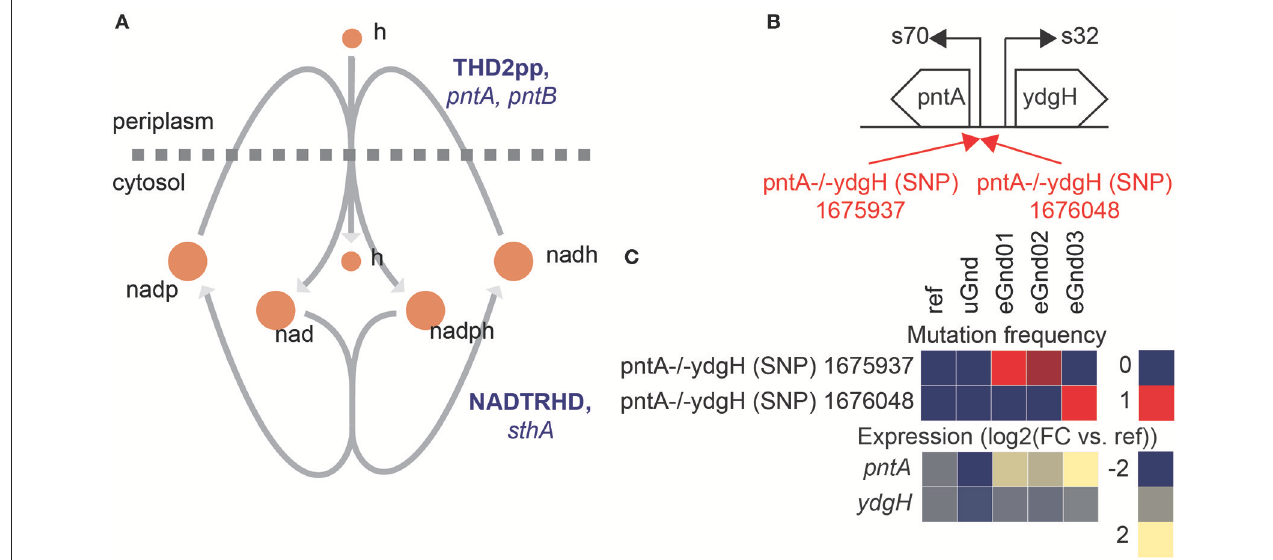
FIGURE 4 | Intergenic mutations that increased gene expression of the NADP(H) binding component of the insoluble pyridine nucleotide transhydrogenase in eGnd strains. (A) Network diagram of the insoluble (THD2pp) and soluble (NADTRHD) pyridine nucleotide transhydrogenase. THD2pp has been shown to provide an important source of NADPH in E. coli ( Sauer et al., 2003). The insoluble pryidine nucleotide transhydrogenase is composed of two subunits encoded by pntA and pntB . The former contains the NADP(H) binding domain while the latter contains the proton pumping transmembrane domain ( Johansson et al., 2005). (B) Operon diagram of pntA . Mutations that affected gene expression of pntA were found in all eGnd strains. The 1675937 SNP is 62 nucleotides downstream of the pntA transcription start site (TSS) and the 1676048 SNP is 49 nucleotides downstream of the pntA TSS. Mutations are annotated in red. (C) Mutation frequency and expression levels of pntA and ydgH . Note that all eGnd strains significantly elevated expression of pntA